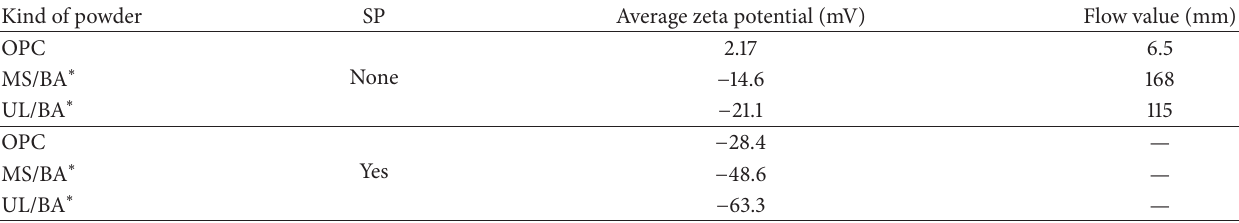
Table 6: Zeta potential and flow value in the system (Termkhajornkit and Nawa (2004) [4]).